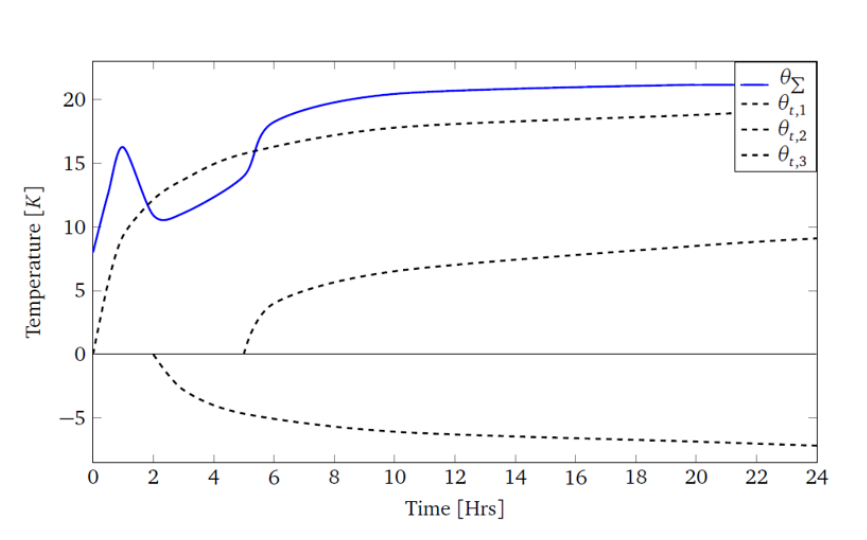
Figure 17. Total transient temperature response of multiple load steps given by Equation (51). Each evaluated temperature transient is calculated using multiple loops and is saved in a matrix. In order to sum the partial transients above an ambient temperature, an ( i × t ) -matrix ∆ θ s storing all partial temperature transients is formed, as shown in Equation